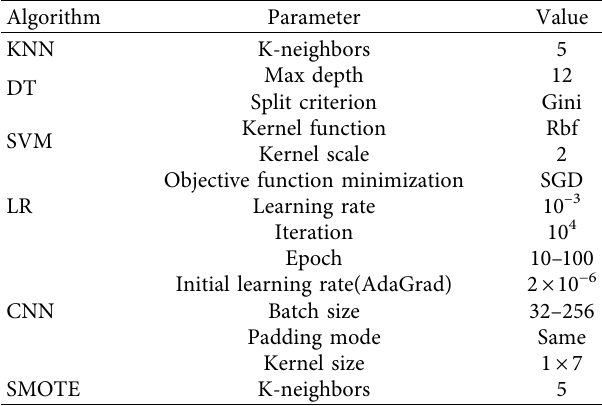
Table 3: The parameters of algorithms.